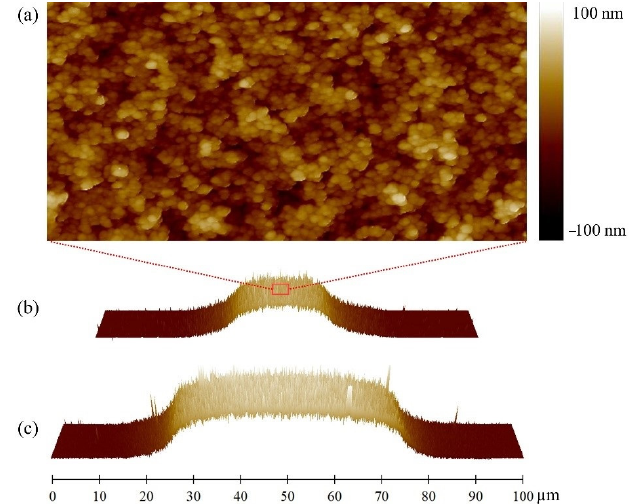
Figure 9. ( a ) Representative AFM topographical map (2 × 1 μ m) of nanostructured zirconia in the center of a 20 μ m large bridge, z-scale ranges from –100 to 100 nm. ( b – c ) Three-dimensional (3D) AFM maps of 50 and 20 μ m large bridges, respectively.